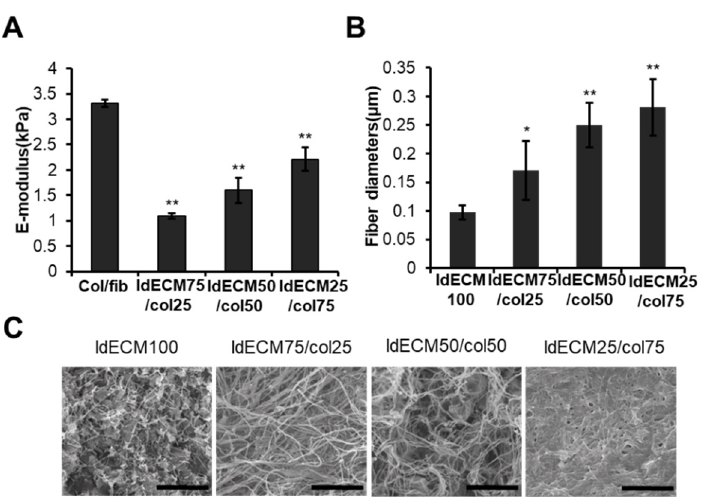
Figure 2. Characterization of TMH hydrogels based on the composition of the 1% ldECM/collagen matrices. ( A ) Compressive E-modulus (Young’s modulus, kPa) of col/fib and 1% ldECM/collagen matrices at various indicated composition. ** p < 0.01 compared with the col/fib group. ( B ) Quantification of fiber diameters in 1% ldECM and 1% ldECM/collagen matrices at various indicated compositions. * p < 0.05, ** p < 0.01 compared with the 1% ldECM 100 group. ( C ) SEM images of 1% ldECM and 1% ldECM/collagen matrices at various indicated compositions.